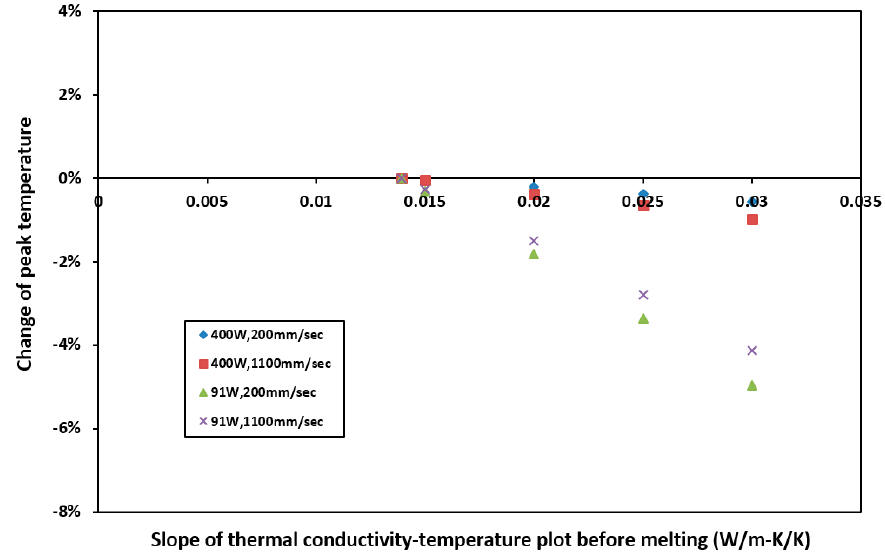
Figure 16. Sensitivity of peak temperature to thermal conductivity. Change of peak temperature with respect to that calculated with base thermal conductivity at varying process parameters. Slope of thermal conductivity–temperature plot before the melting point is varied only.